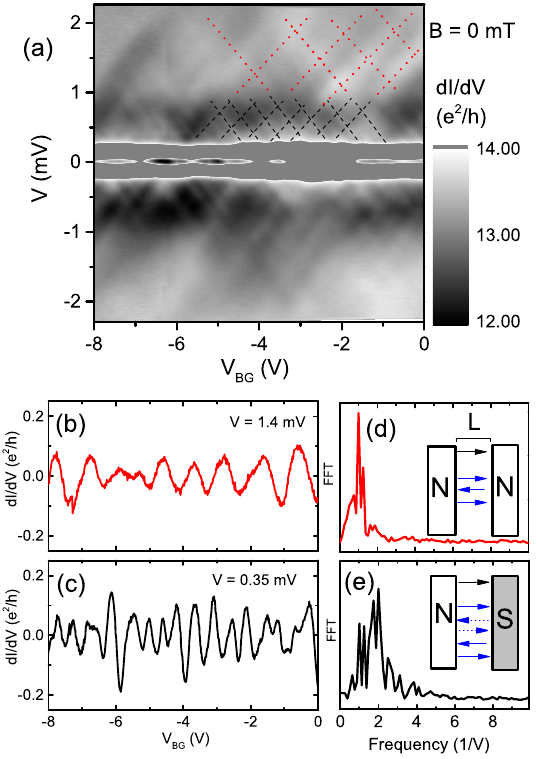
FIG. 3. (a) Color plot of dI=dV versus source-drain bias V and accentuating the high-bias features. Red backgate bias V BG dotted lines are guides to the eye to indicate the checkerboard pattern for conventional Fabry-Pérot oscillation at high bias. Black dashed lines follow the low-bias features for de Gennes – Saint-James resonances. (b),(c) Plots of differential conductance versus backgate bias for two different values of source-drain bias V ; in both cases, we subtract a slowly varying background. Panel (b) shows the Fabry-Pérot oscillations at high bias, with period Δ V ≈ 1 V; corresponding FFT is shown in (d). Panel (c) shows BG the low-energy de Gennes – Saint-James resonances with period Δ V ≈ 0 . 5 V; corresponding FFT is shown in (e). The illus- BG trations in insets of (d) and (e) symbolize the two sets of particle trajectories for Fabry-Pérot resonances (with electrons only) and de Gennes – Saint-James resonances (mixture of holes and elec- trons), respectively. Solid arrows represent the trajectories of electrons while dashed arrows represent those of holes. Trans- mitted particles are shown in black while reflected particles are BG shown in